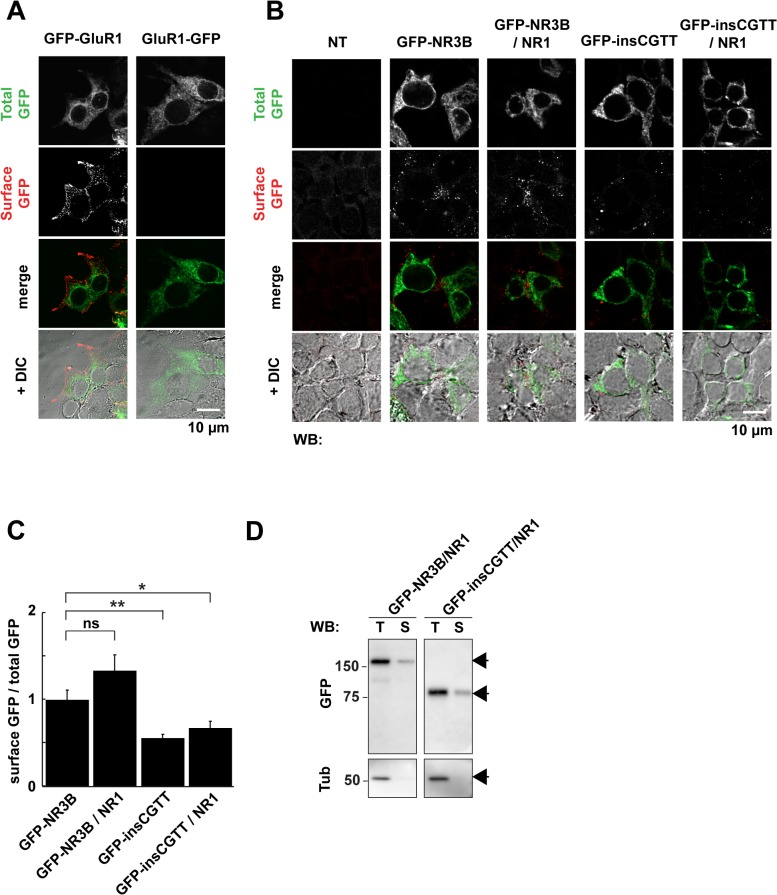
Effect of insCGTT type on distribution of NR3B in HEK293T cells.
A, HEK293T cells transfected with GluR1 tagged with GFP at the extracellular N-terminus or intracellular C-terminus were stained with a GFP antibody under non-permeabilized conditions on ice, as verification of the specificity of cell surface receptor detection using immunostaining. B, HEK293T cells transfected with GFP-tagged NR3B major type or insCGTT type (green) were stained with GFP antibody under non-permeabilized condition to detect the cell surface population (surface GFP, red). C, Quantification of the surface levels of NR3B major type and insCGTT type with and without NR1. Because expression level of major type and insCGTT were different, the level was normalized by total GFP fluorescence in each cell. Data are expressed as a normalized value to that of major type alone. n = 55, 52, 59, and 52 for GFP-NR3B major type only, GFP-NR3B major type with NR1, GFP-NR3B insCGTT type only, and GFP-NR3B insCGTT type with NR1, respectively. *: p < 0.05; **: p < 0.01; ns: not significant. D, Surface biotinylation of NR3B major type and insCGTT type. GFP-tagged NR3B major type or insCGTT type was coexpressed with NR1 in HEK293T cells and the surface population was labeled by biotin. NR3B types in both total (T) and biotinylated surface population (S) were detected by anti-GFP antibody. Total fractions represent 1/8 of the starting material applied in surface fractions. α-Tubulin (Tub), an intracellular protein, was not biotinylated, confirming specificity of surface biotinylation.